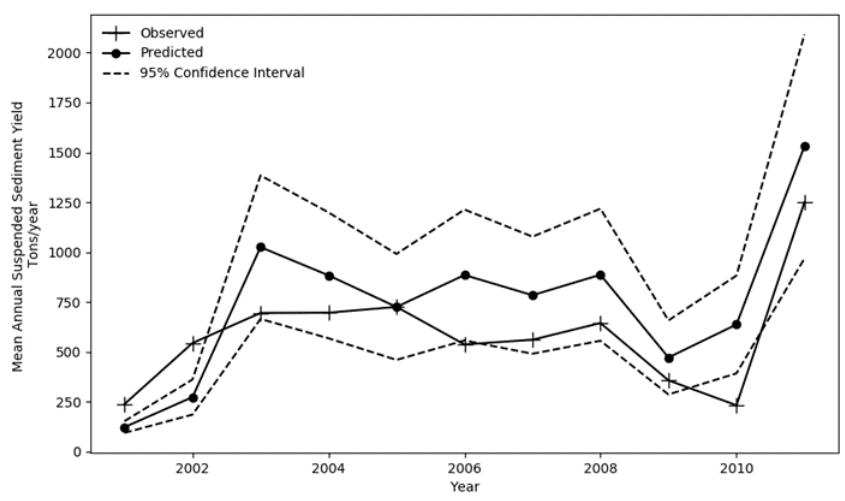
Figure 10. 95% Confidence interval for suspended sediment yield by MLR model.